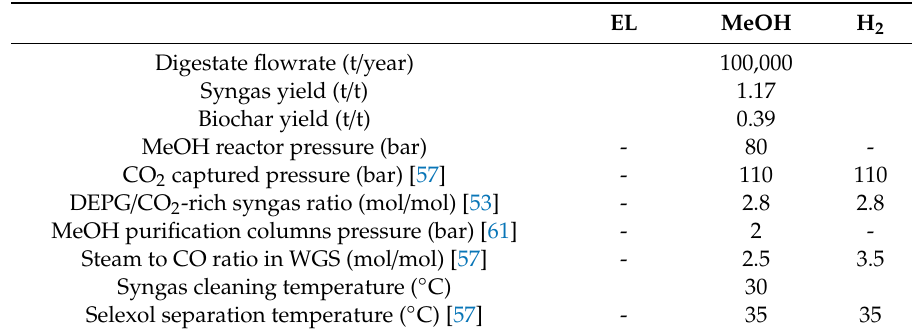
Table 4. Process simulation parameters.